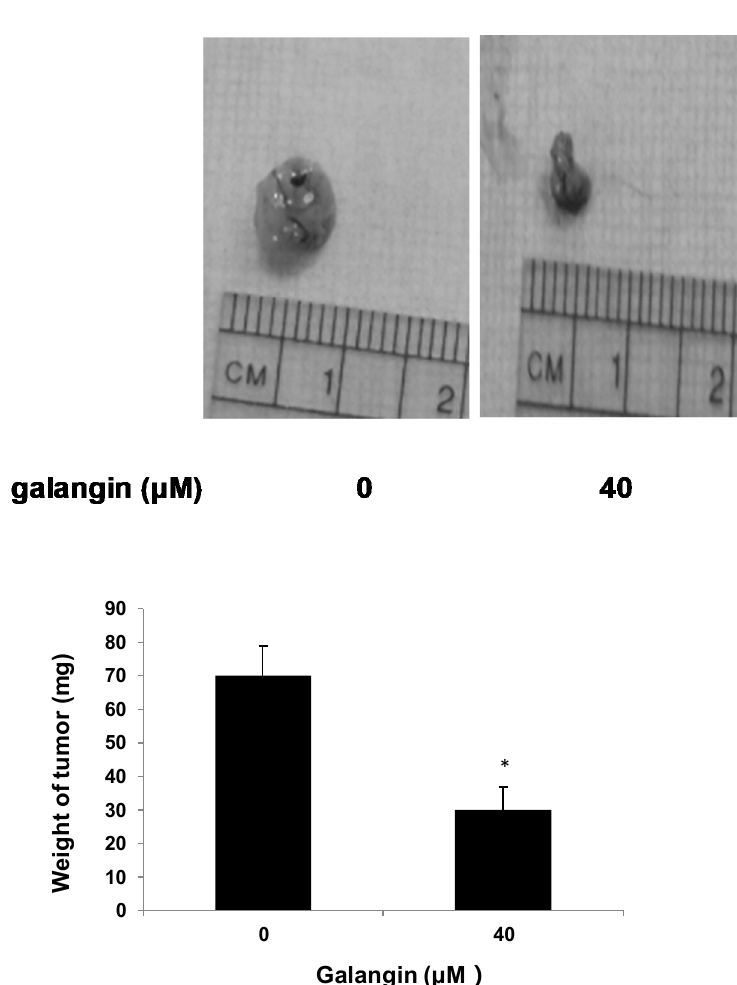
Figure 3. Effect of galangin on the proliferation of ovarian cancer cells by CAM assay. Aliquots of OVCAR-3 cells (20 µ L, 6 × 10 7 / mL) were mixed with 80 µ L of Matrigel and supplemented with 0- or 40- µ M galangin. The mixture was implanted onto the CAM of the 9-day-old chicken embryo. Chicken embryos were incubated for another 5 days. Tumor implants were weighed using an electronic scale. * p < 0.05 as compared to the control.